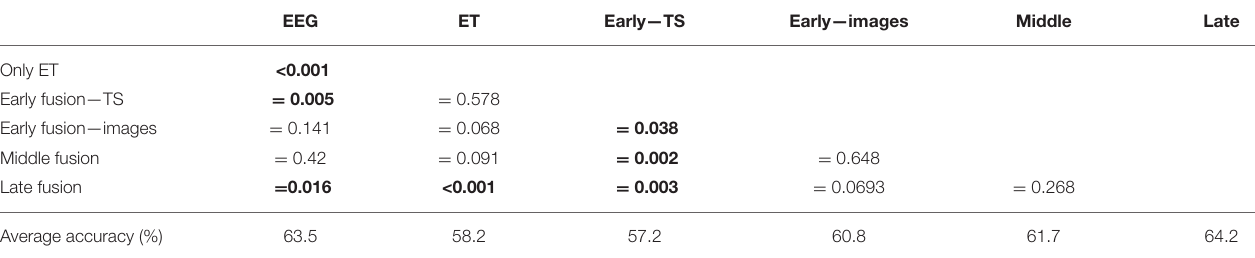
TABLE 3 | P -values of two-tailed paired t -test for the comparison of the feature fusion approaches. EEG ET Early—TS Early—images Middle Late